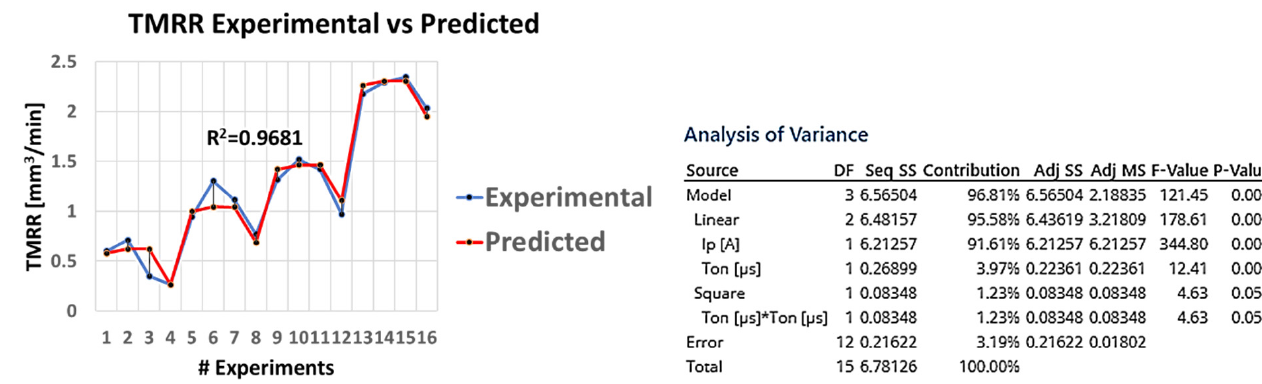
Figure 6. Plot of experimental TMRR vs predicted MRR along with model’s ANOVA.